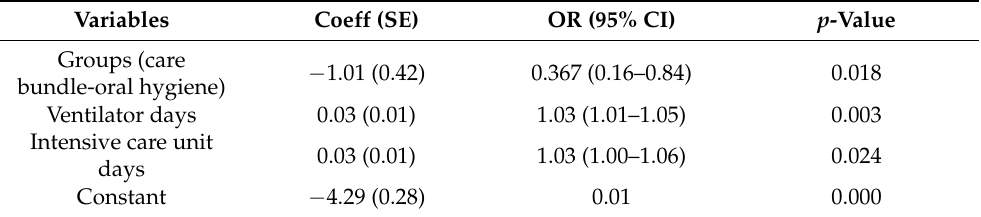
Table 4. The Logistic Regression Model for Predicting Ventilator-Associated